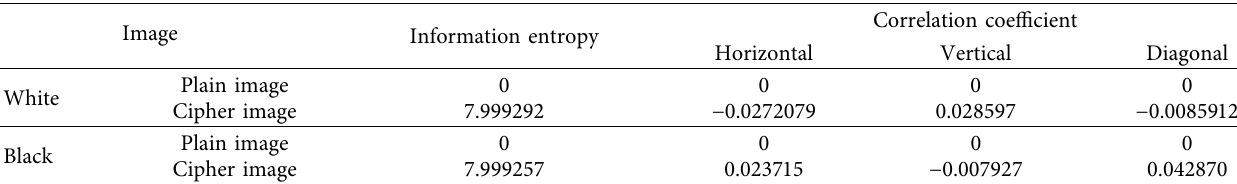
Figure 8: Plain and cipher histograms and images: (a) plain black image; (b) plain white image; (c) histogram of the cipher image of the black image; (d) cipher image of the black image; (e) cipher image of the white image; and (f) histogram of the cipher image of the white image. Table 5: Information entropies and correlation coefficients of the cipher images.